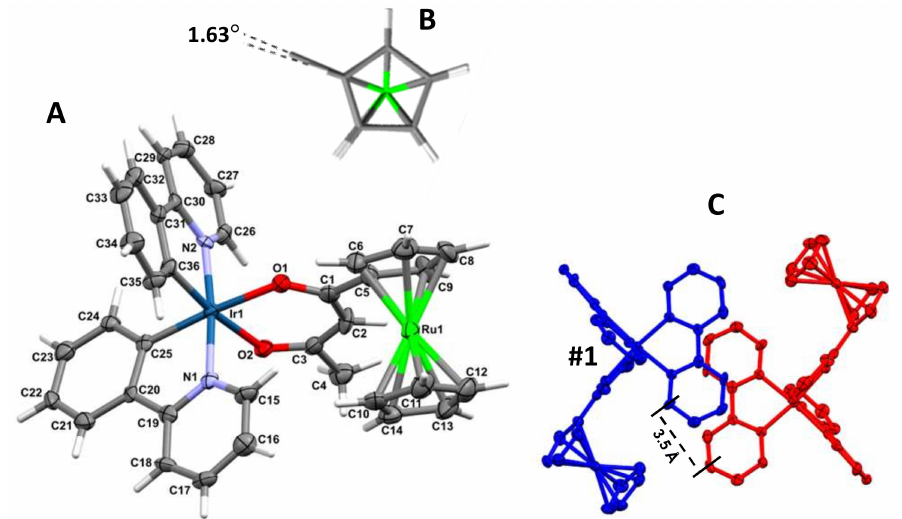
Figure 1. Left, A: Molecular structure of [(ppy) 2 Ir(RcCOCHCOCH 3 )] ( 3 ) showing atom labeling and, B , the ruthenocenyl group from above highlighting the near-eclipse configuration. The thermal ellipsoids represent a 50% probability limit. For clarity, a co-crystallized molecule of CH 2 Cl 2 have been omitted. Right: C shows the crystal packing for 3 , with the foreground molecule labelled #1 in blue and viewed perpendicular to the ppy ligand plane of the molecule (red) in the background. The perpendicular π – π spacing between the ppy ligands of adjacent molecules is ca. 3.5 Å. Selected bond distances (angstroms) are: Ir(1)–N(1) 2.046(7), Ir(1)–N(2) 2.045(7), Ir(1)–C(36) 1.987(8), Ir(1)–C(25) 1.992(9), Ir(1)–O(1) 2.112(6),